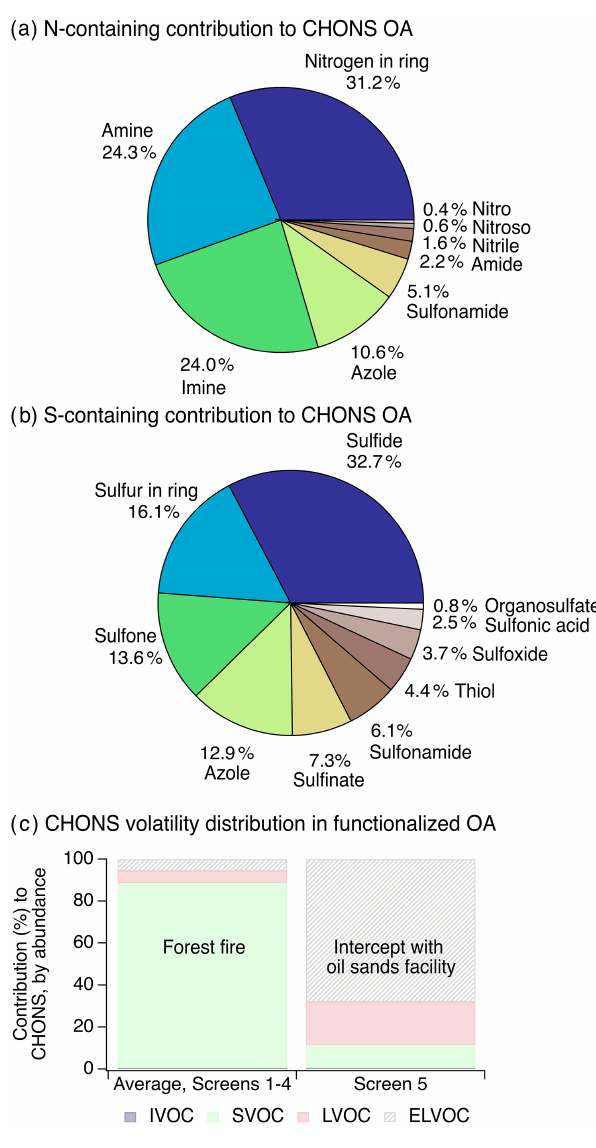
Figure 2. (a) The distribution of nitrogen-containing functional groups to particle-phase CHONS compounds (organonitrates are excluded here due to challenges with their identification using SIR- IUS with CSI:FingerID, but contributed minimally to CHONS, Sect. S3). (b) The distribution of sulfur-containing groups to particle-phase CHONS compounds. For panels (a–b) , data are aver- aged across screens 1–4, with individual screens shown in Fig. S7a. (c) Volatility distribution of particle-phase CHONS species. These volatility data were averaged across screens 1–4, and individual screens are shown in Fig. S8. Volatility was estimated with the pa- rameterization in Li et al. (2016) and grouped according to volatility bins in Donahue et al.